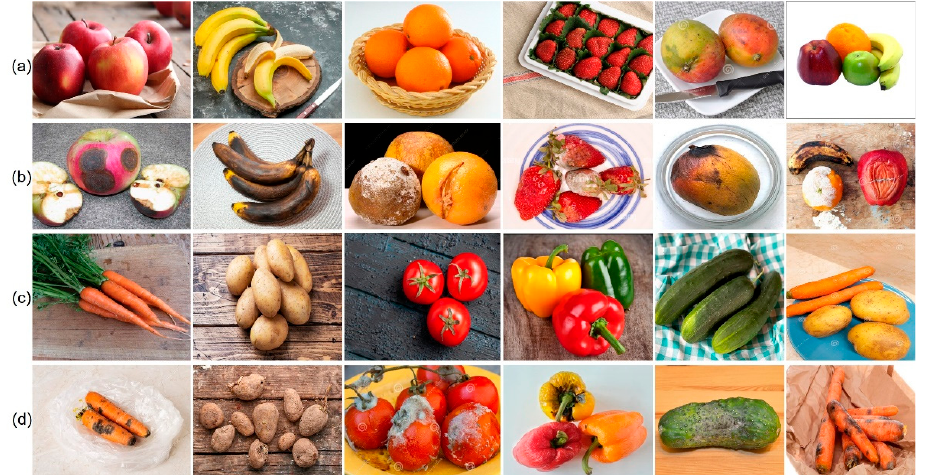
Figure 1. Sample images of fruit and vegetable dataset with multiple objects and various back-